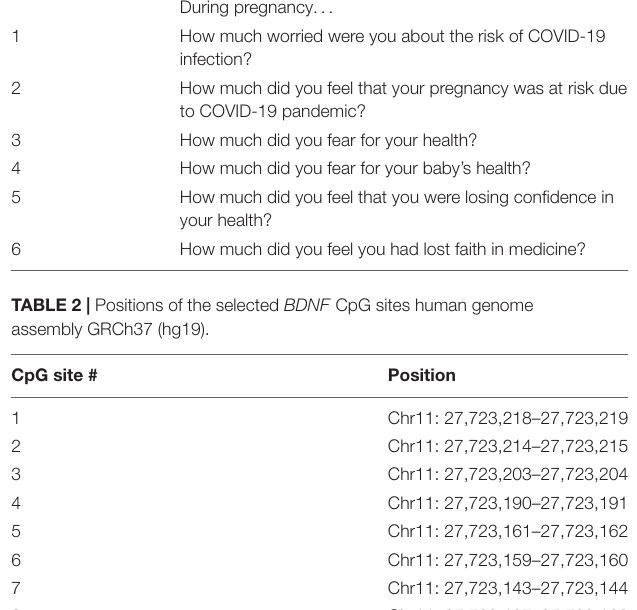
TABLE 1 | Pandemic-related stress questionnaire. Pandemic-related stress (Response: 5-point Likert scale) During pregnancy ...